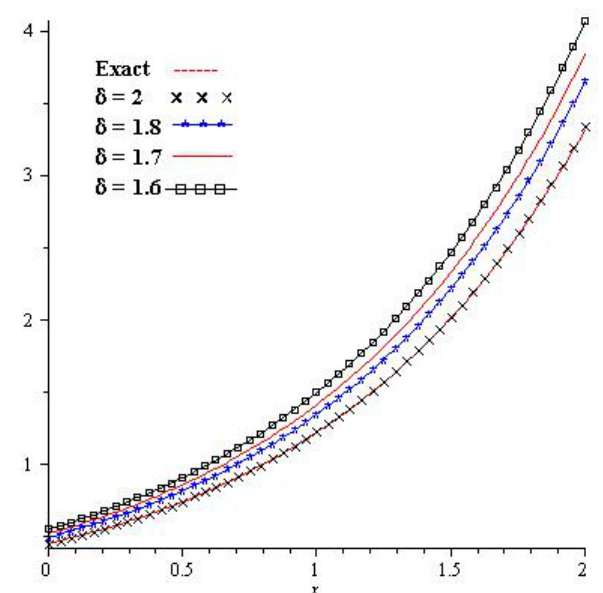
Figure 4. NTDM solution of Example 2 at different fractional-order δ =